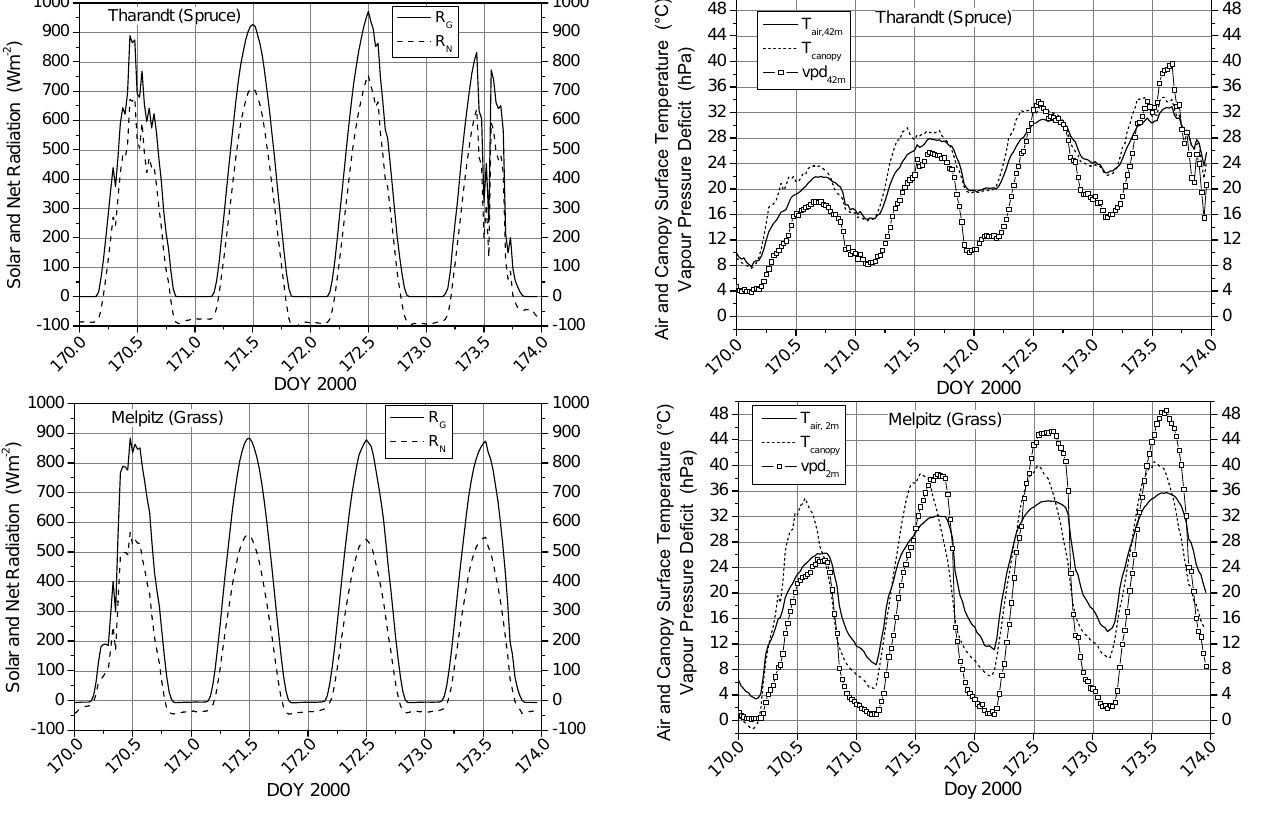
at leaf surface level by opening and closing the stomata com- bined with low values of the decoupling coefficient. Accord- ingly, the second site shows the stronger dependence of sur- face evapotranspiration of a grass site on available energy combined with relatively high mean values of omega. This results in distinctly higher omega values for the grass site in Melpitz during the complete investigated period. The various modifications of omega lead to different devi- ations from the origin approach. In Fig. 9 the omega values of the three modifications (referring to Eqs. 2 to 4 and Fig. 8) are plotted versus the original omega approach (Eq. 1). The results show that the absolute differences between these ap- proaches increase continuously with increasing omega rang- ing from 0 to 0.35 and remain constant for higher values of omega. At the forest site the increasing differences of omega are possibly caused by a more random link between canopy ( g c ) and aerodynamic conductance ( g a ) due to a reduced g c for higher values of g a (Fig. 10 above). This fact